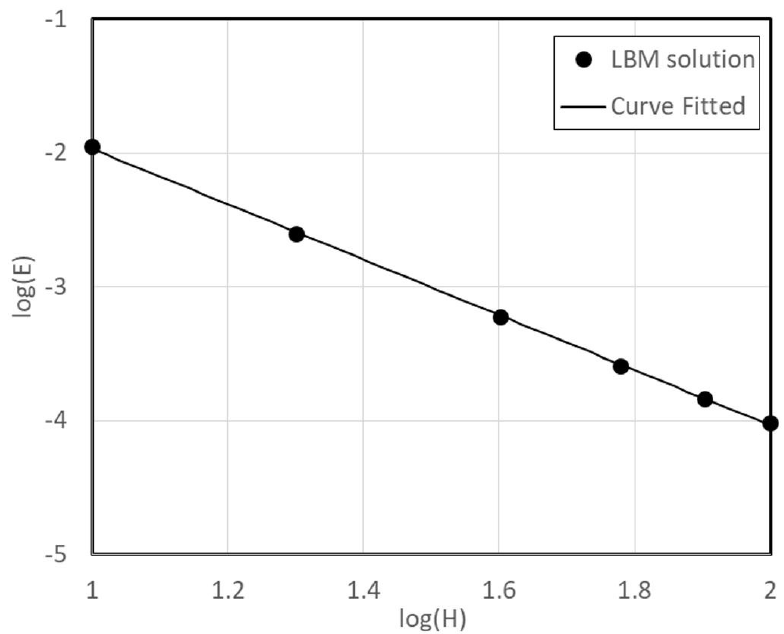
Figure 14. Variation of relative global error for the Poiseuille